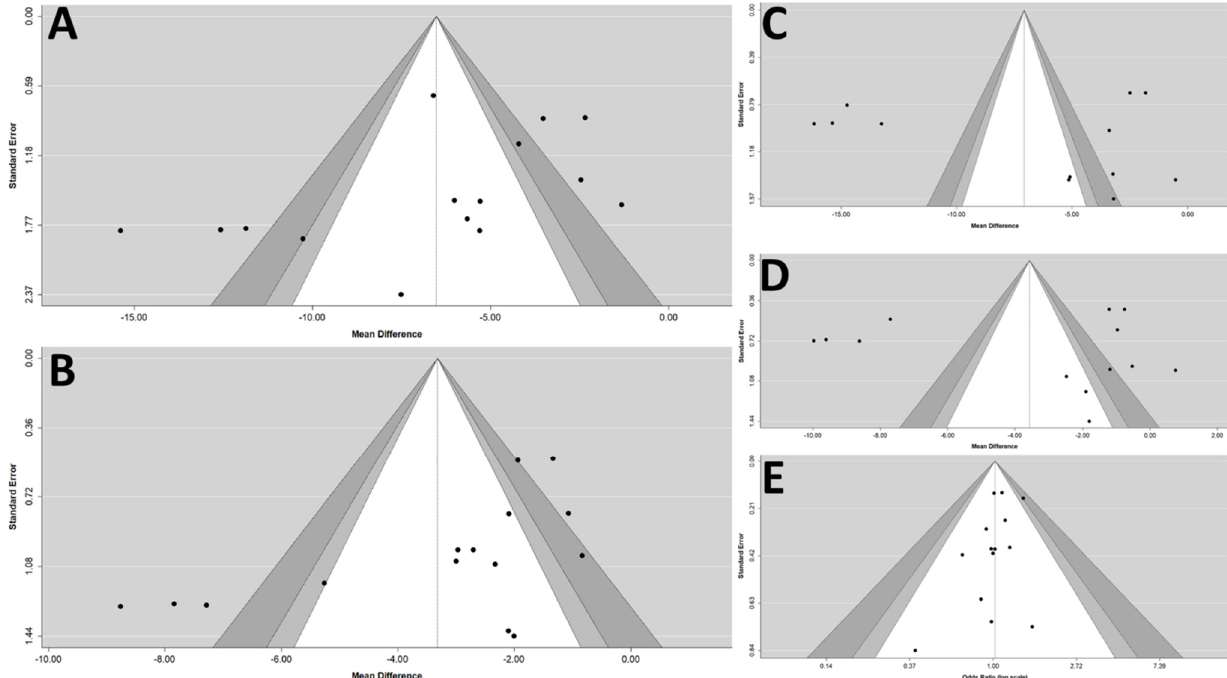
Figure 5. Funnel plots of ( A ) msSBP, ( B ) msDBP, ( C ) maSBP, ( D ) maDBP, and ( E ) adverse events. maSBP, mean ambulatory systolic blood pressure; maDBP, mean ambulatory diastolic blood pressure; msSBP, mean sitting systolic blood pressure; msDBP, mean sitting diastolic blood pressure.